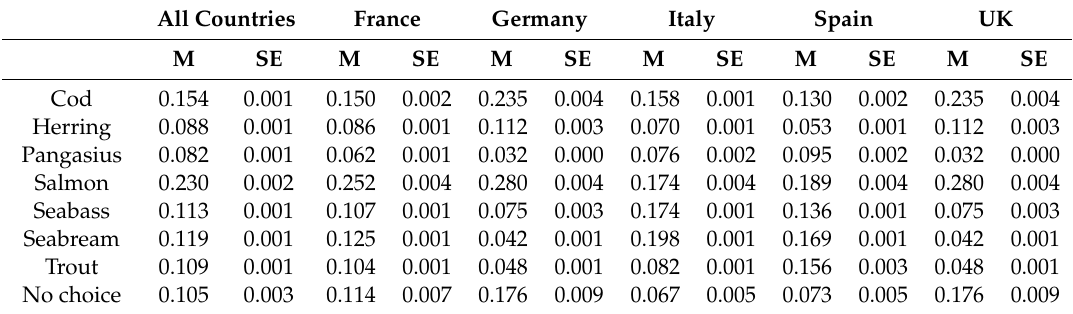
Table 4. Choice probability obtained by Mixed Logit (ML) models (M, mean; SE, Monte Carlo standard